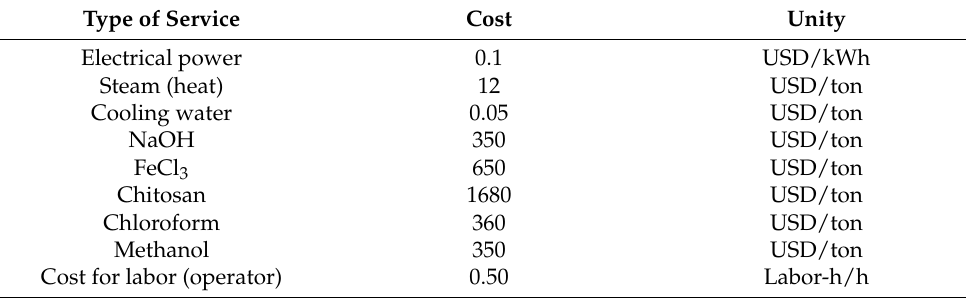
Table 4. Service and raw material costs.